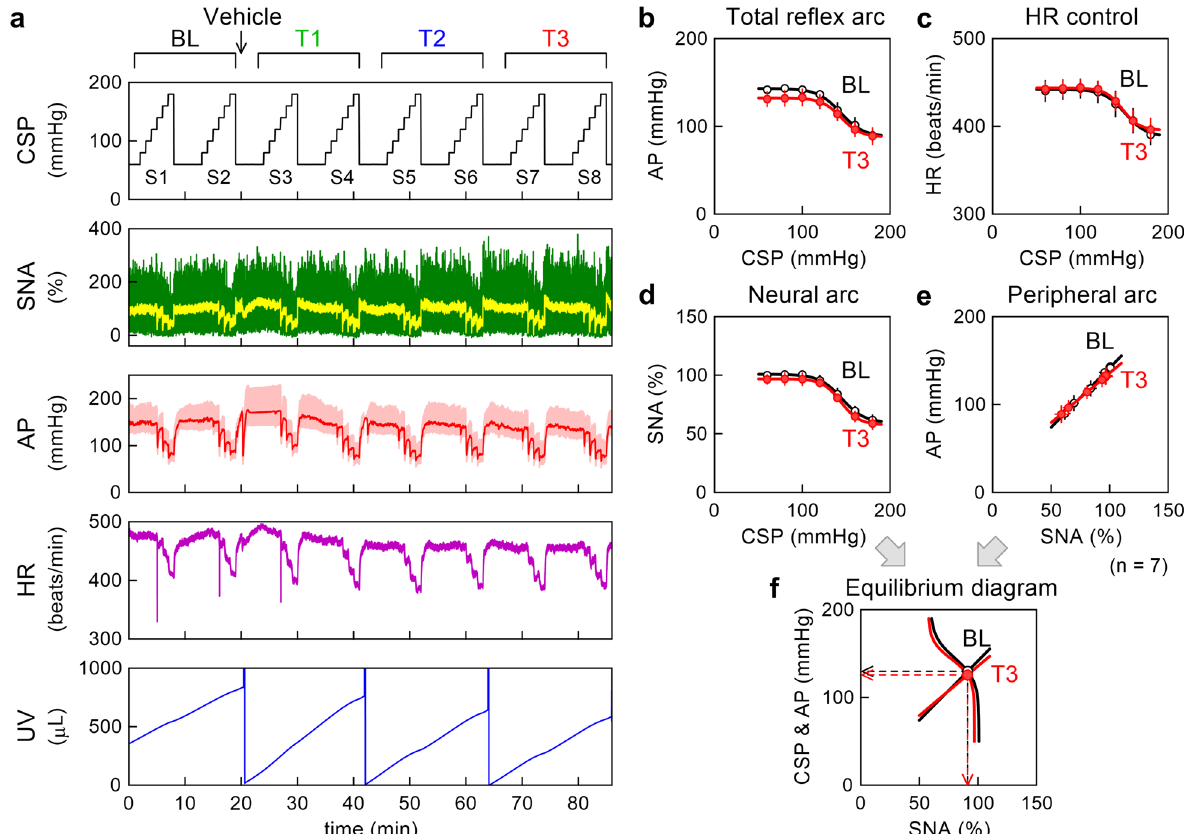
Fig. 1 a An example time series obtained from a Goto–Kakizaki rat in the vehicle group. Carotid sinus pressure (CSP), sympathetic nerve activity (SNA), arterial pressure (AP), heart rate (HR), and urine volume (UV) during stepwise input sequences (S1–S8) are shown. In the CSP, HR, and UV plots, the data illustrate 10-Hz resampled signals. In the SNA plot, 10-Hz resampled (green) and 2-s moving averaged (yellow) signals are shown. In the AP plot, 100-Hz resampled (pale red) and 2-s moving averaged (red) signals are shown. In the UV plot, sharp reductions with vertical artifacts indicate manual urine removals. The data were divided into baseline (BL), T1, T2, and T3 periods of two input sequences each. The vehicle solution was administered one minute after the completion of S2. b – e Pooled data showing the total reflex arc, HR control, neural arc, and peripheral arc. The black lines with open circles represent the data obtained during BL. The red lines with filled circles represent the data obtained during T3. The data points represent mean SE values (n 7 rats). f Baroreflex equilibrium diagrams derived from fitted neural and peripheral arcs. The black open ± = circle and the red filled circle indicate the operating points during BL and T3, respectively. The leftward arrowheads indicate the AP values at the operating points. The downward arrowheads indicate the SNA values at the operating